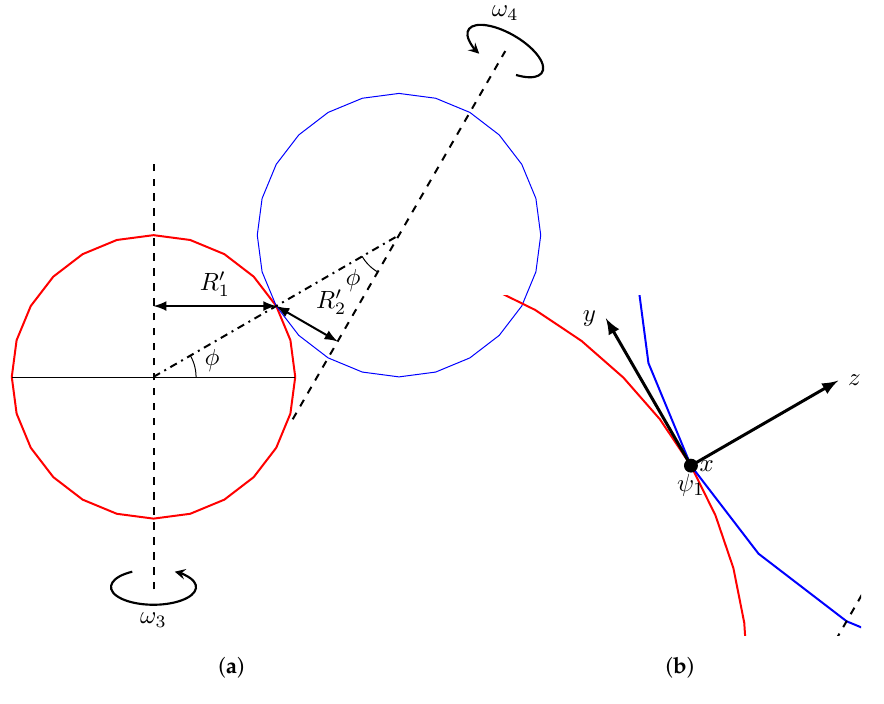
Figure 1. A conceptual drawing of the Dual-Hemi CVT. To change the transmission ratio, the blue hemisphere rolls over the red one around the x -axis of the frame ψ 1 in the point of contact (black dot in the figure). ( a ) An overview drawing of the conceptual mechanism. ( b ) A zoom on the contact point, with the addition of frame ψ 1 . (The initial idea of the Dual-Hemi CVT is by Peter Rutgers, DEMCON, Enschede, The